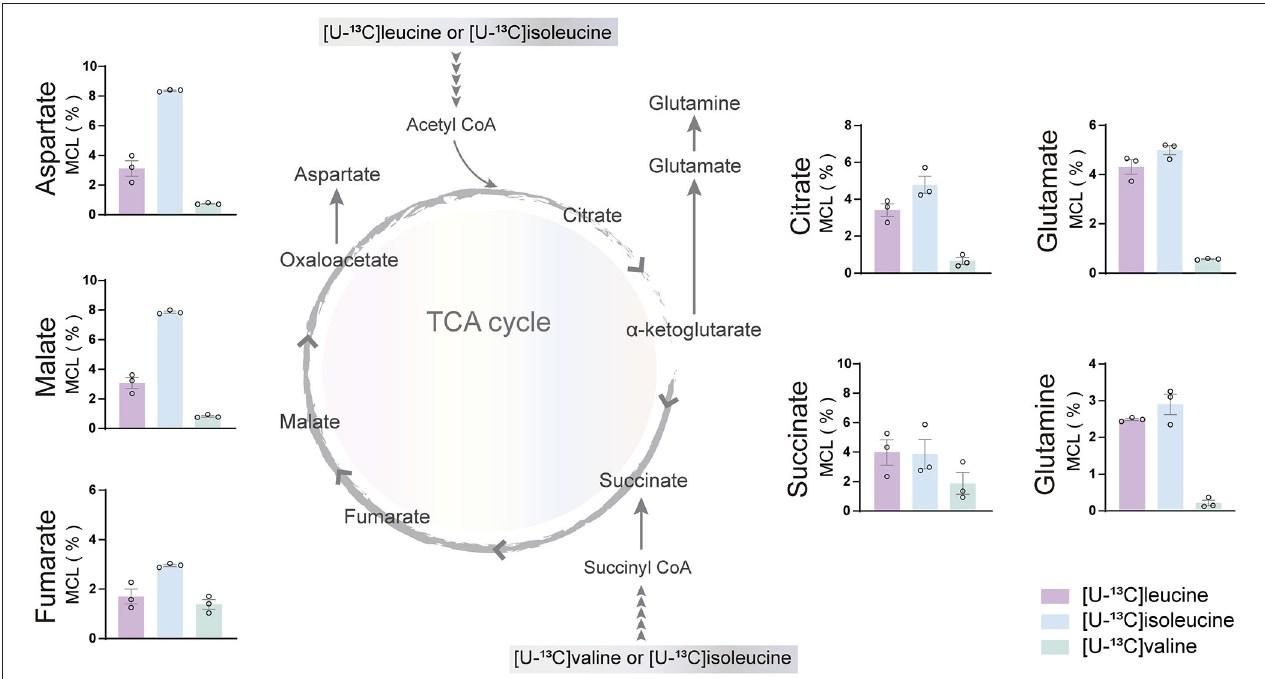
FIGURE 4 | BCAA oxidative metabolism in human induced pluripotent stem cell (hiPSC)-derived astrocytes. hiPSC-derived astrocytes were incubated with [U- 13 C]isoleucine, [U- 13 C]leucine, or [U- 13 C]valine. Labeling in TCA cycle intermediates and amino acids represented as molecular carbon labeling (MCL) confirms hiPSC-derived astrocytes capability to oxidatively metabolize the BCAA isoleucine, leucine, and, to a lesser extent, valine by incorporating them in the TCA cycle. Values represent mean ± SEM ( n = 3) from different hiPSC-derived astrocyte set-ups individually depicted as